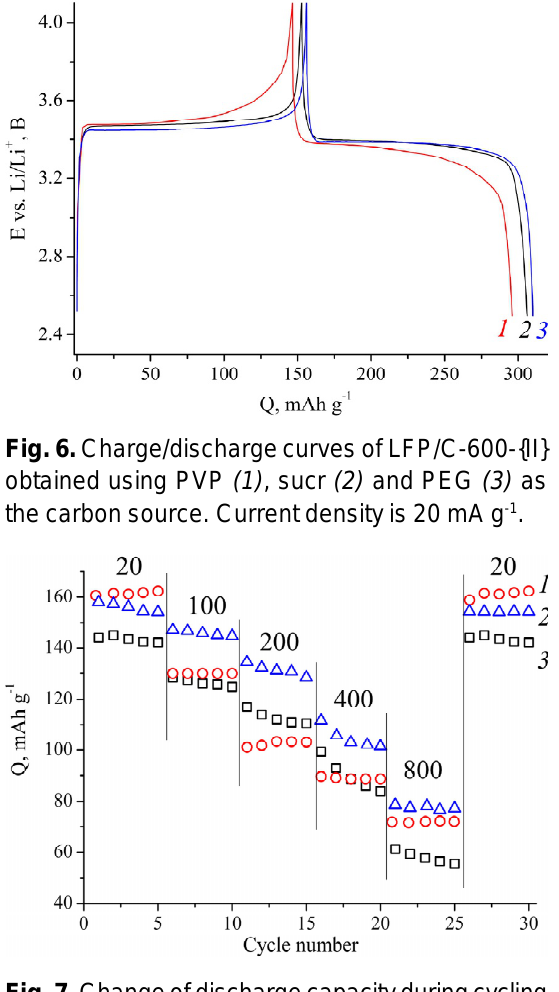
Fig. 7. Change of discharge capacity during